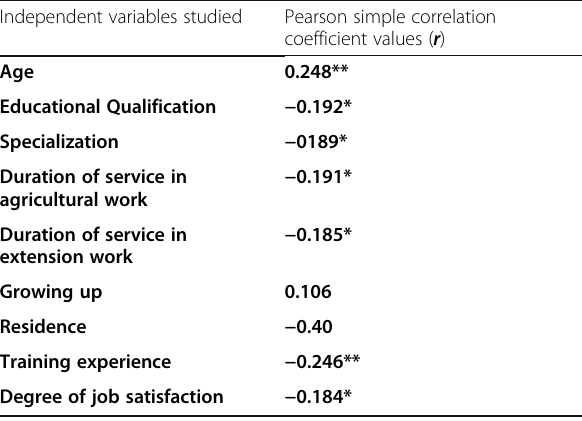
Table 9 The correlation coefficients for the relationship between the training needs of agricultural extension workers in the field of biological control and some independent variables Independent variables